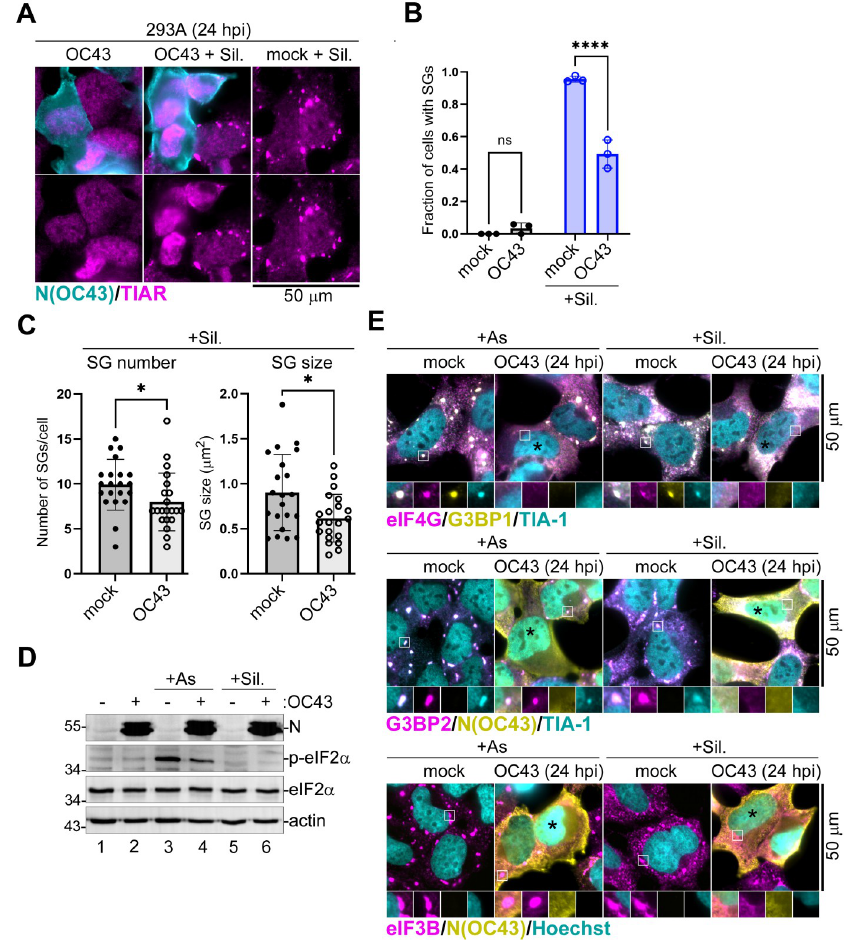
Fig 2. OC43 inhibits SGs independently of eIF2 α phosphorylation. 293A cells were infected with OC43 at MOI = 1.0 and SG formation in arsenite (+ As), Silvestrol (+ Sil.), and untreated mock and OC43 infected cells was analyzed at 24 hours post-infection (hpi) using immunofluorescence staining for nucleoprotein and the indicated SG markers. (A) Immunofluorescence analysis of SG formation in mock infected and OC43-infected cells treated with Silvestrol (+ Sil.) or untreated infected cells. (B) Fraction of cells with SGs was quantified in mock and OC43-infected 293A cells treated and stained as in panel (A). Each data point represents independent biological replicate (N = 3). Error bars = standard deviation. Two-way ANOVA and Tukey multiple comparisons tests were done to determine statistical significance ( ���� , p -value < 0.0001, ns = non-significant). (C) TIAR-positive SG number per cell and average SG size per cell were quantified in mock and OC43-infected 293A cells treated and stained as in panel (A). Each data point represents individual cell analysed from 3 independent biological replicates (21 cells per condition). Error bars = standard deviation. Two-tailed Students t-Test was done to determine statistical significance. ( � , p -value < 0.05). (D) Phosphorylation of eIF2 α was analysed by western blot. (E) Representative images of mock infected and OC43 infected cells immunostained for SG markers eIF4G (magenta), G3BP1 (yellow), TIA-1 (teal), G3BP2 (magenta), and eIF3B (magenta) as indicated. Subcellular distribution of nucleoprotein (N(OC43), yellow) was visualised by immunostaining and nuclear DNA was visualised with Hoechst dye (teal) where indicated. Black asterisks indicate infected cells that did not form SGs. Outsets show enlarged areas of cytoplasm with separation of channels to better visualize co-localization of SGs markers. Scale bars = 50 μ